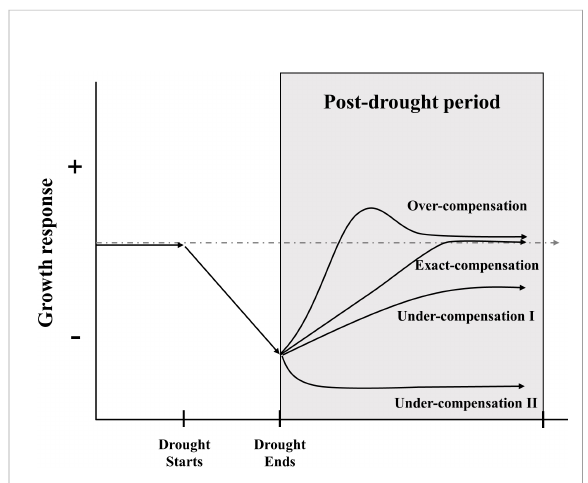
FIGURE 1 Framework for describing the growth response of grassland ecosystem after drought ends. The grey and dashed line represents growth response in condition without drought, the solid line indicated possible compensatory patterns under drought. Over-compensation means the growth rate increase rapidly after the end of a drought, then exceed the response level of control treatment to some extent, and fi nally reach the same response level of control treatment; exact-compensation represents the growth rate return to be comparable with control treatment after drought; under-compensation I indicates that the growth rate cannot reach the same level of control treatment with slow growth rate; under-compensation II denotes the collapse of grassland ecosystem with much slower growth rate (Frank et al., 2015; Li et al., 2021; Vilonen et al.,